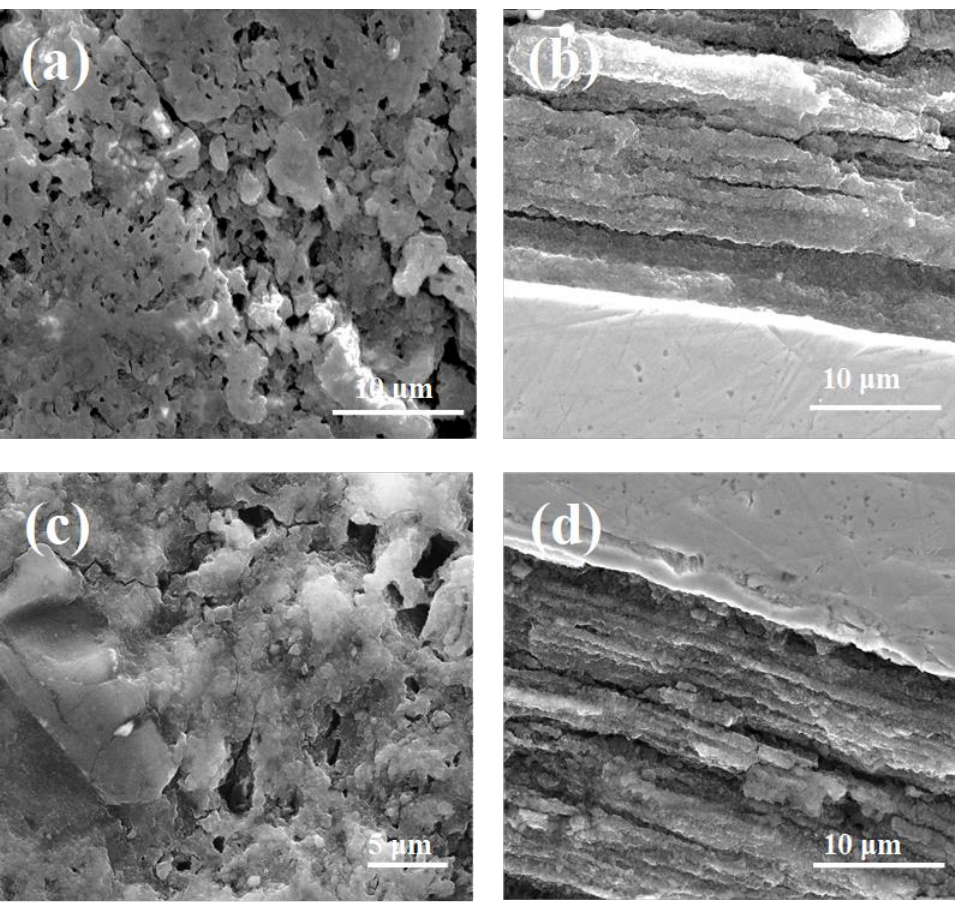
Figure 3. SEM images of 10% SiC MgB 2 wires with a 0.83 mm diameter: ( a ) cross-section and ( b ) longitudinal section for sample H (1 GPa, 725 °C, 15 min) and ( c ) cross-section and ( d ) longitudinal section for sample I (1 GPa, 700 °C, 25 min). The metal sheath is the Nb barrier. However, the longer annealing time produces a higher density structure compared to sample H, which was heated at a higher temperature. The investigation showed that Mg at 1 GPa transitions from the solid state to the liquid state at approximately 720 ◦ C